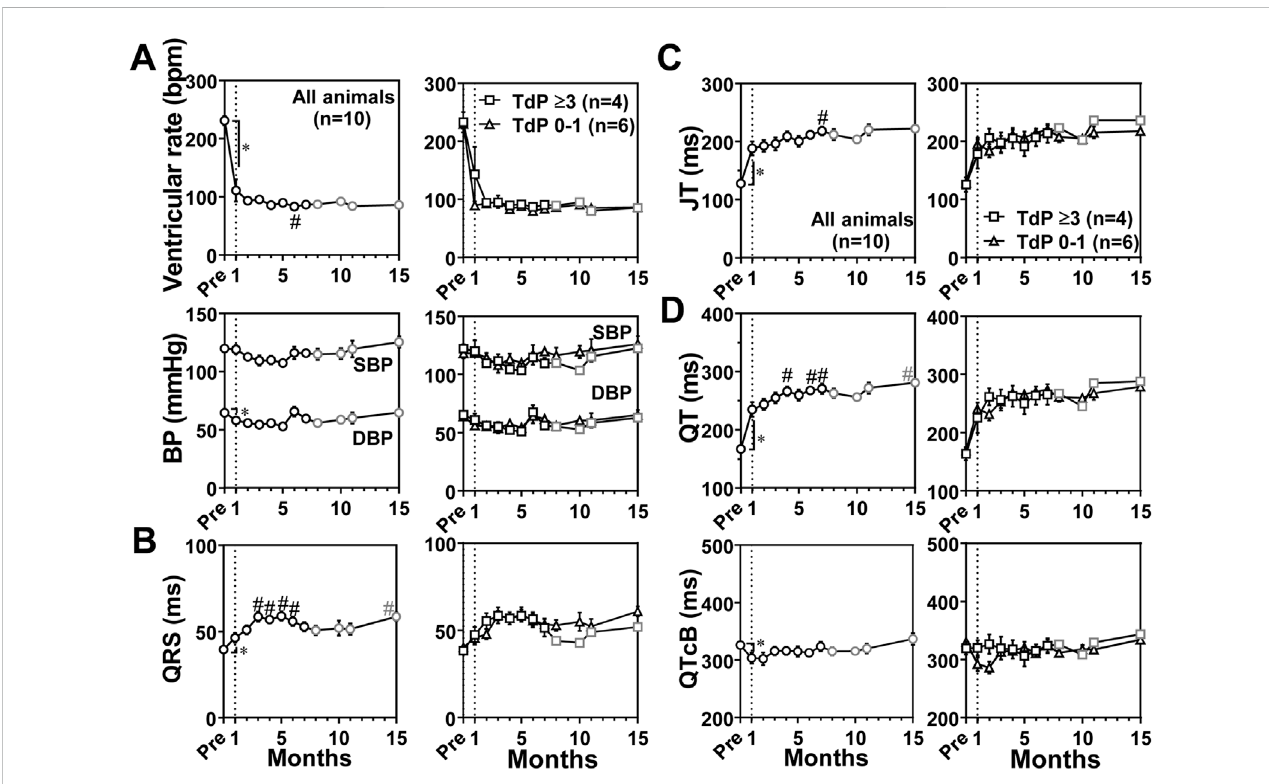
FIGURE 3 Time courses of changes in the ventricular rate and systolic/diastolic blood pressures (SBP/DBP) (BP) (A) and electrocardiographic variables including QRSwidth(QRS) (B) ,JTinterval(JT) (C) ,andQTinterval(QT)andQTintervalcorrectedbyBazett ’ sformula(QTcB) (D) intheatrioventricularblockmonkeysin consciousstate. In theleft of each panel, mean values ofall animals (All animals)are shown (black symbols, n = 10 for Pre and 0 – 7 months; and gray symbols, n = 8 for 8 – 15 months); and in the right of it, averaged values in animals exerting torsade de pointes 0 – 1 time (TdP 0 – 1, triangles, n = 6) and those exhibiting torsade de pointes ≥ 3 times (TdP ≥ 3, black squares, n = 4 for Pre to 7 months; and gray squares, n = 2 for 8 – 15 months) by dl -sotalol challenge are depicted. Data are presented as mean ± s.e.m. * p < .05, before atrioventricular block (Pre) vs. 1 month by Wilcoxon matched-pairs signed rank test; and # p < .05, vs. 1 month by Friedman test with Dunn ’ s multiple comparison